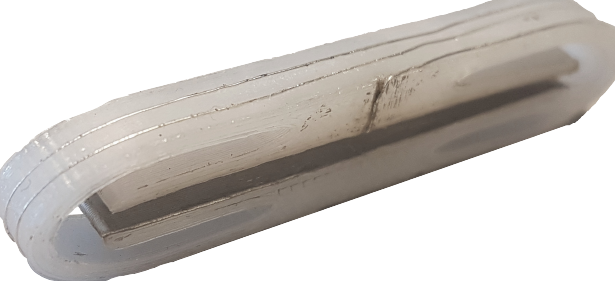
Figure 2. Experimental transducer of a single-component force.